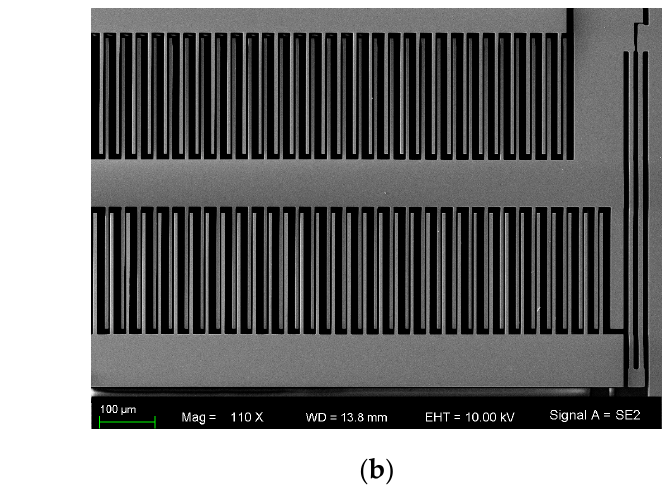
Figure 6. The SEM ( a ) and image of MEMS sensor ( b ).